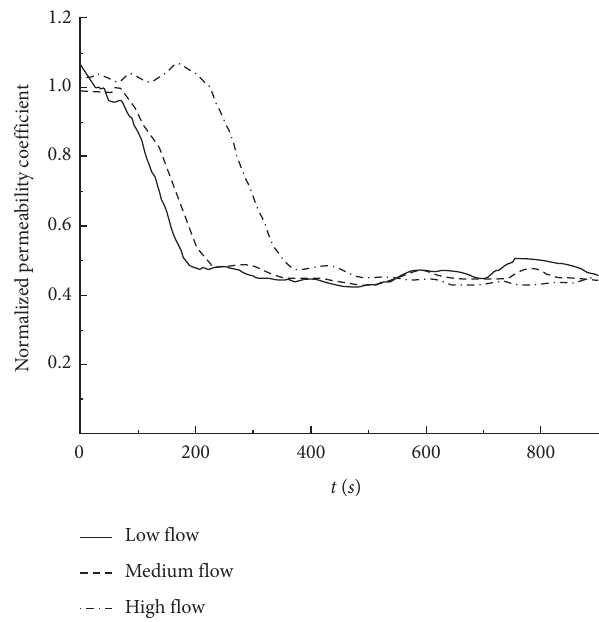
Figure 9: Different flow rates result in normalized permeability coefficients after